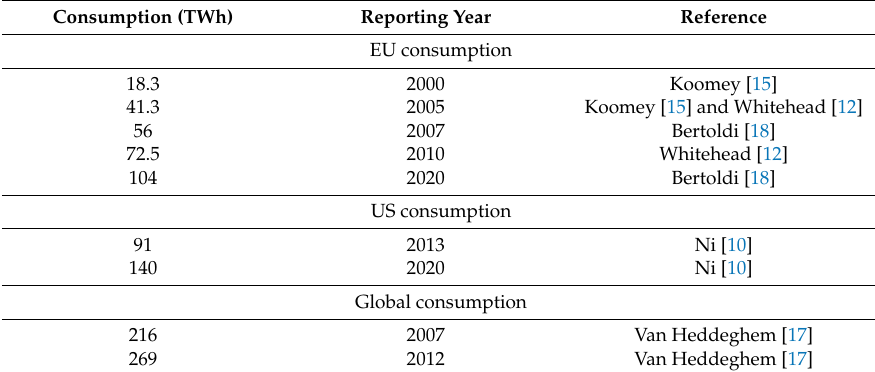
Table 1. Energy consumption estimations and projections in TWh from a European, American and Global